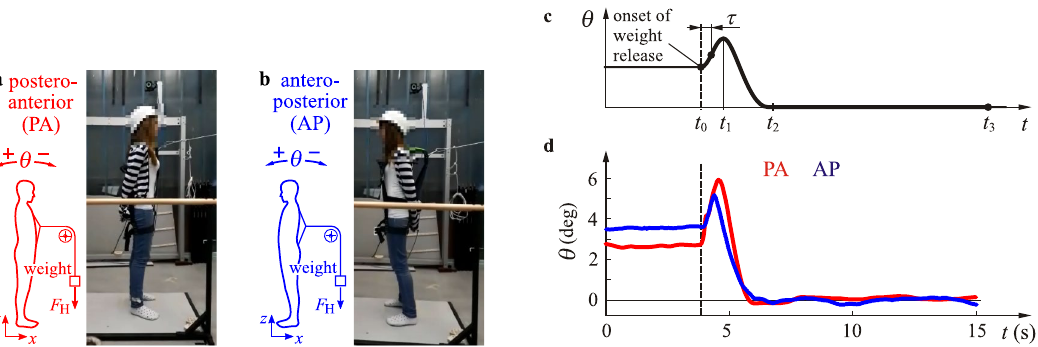
Figure 2. Experimental setup and responses. ( a,b ) Setup for posteroanterior (PA) and anteroposterior (AP) direction. ( c ) Typical time response and some characteristic time instants, t 0 : onset of perturbation, t 1 : maximum excursion, t 2 : recovery to normal posture, t 3 : end of the trial. ( d ) Sample time signals measured during PA (red) and AP (blue)